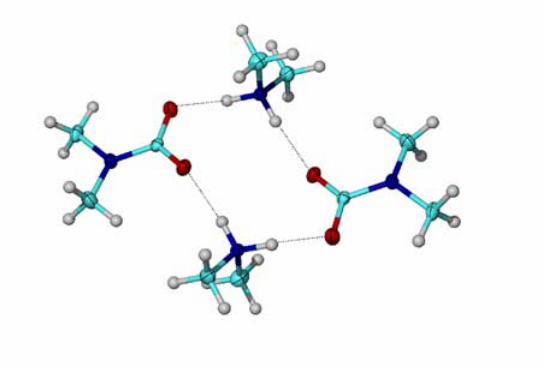
Figure 1. The single crystal X-ray structure of